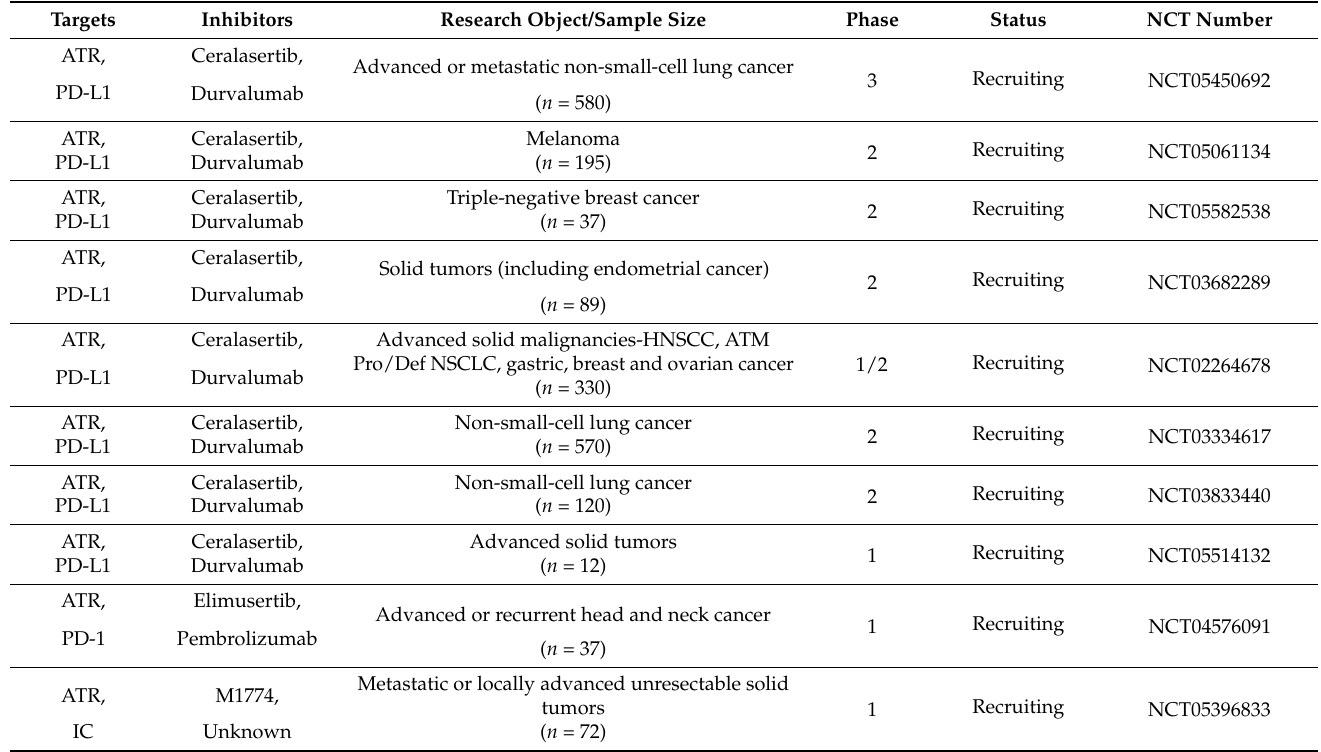
Table 3. Ongoing clinical trials pertaining to DNA damage response inhibitors in combination with immune checkpoint